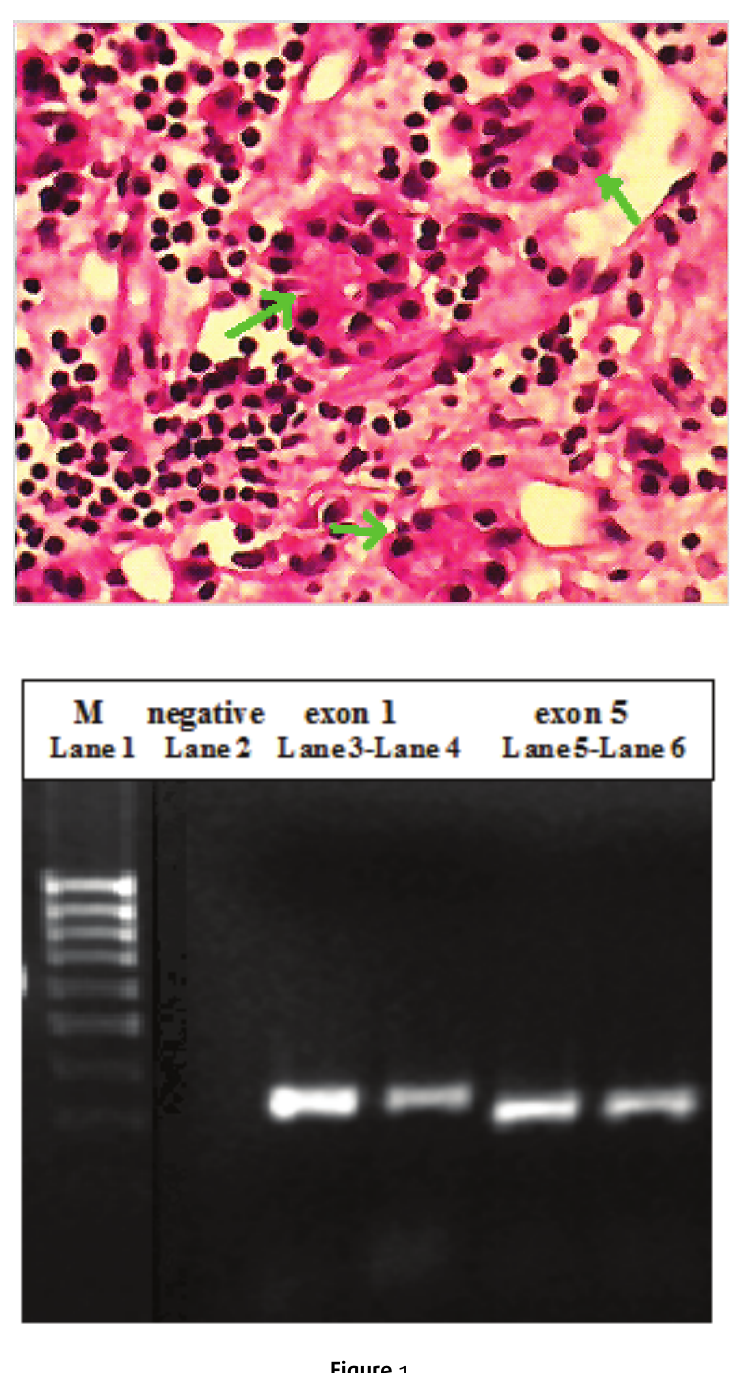
PCR products on acrylamide gel using SSCP analysis was performed on apparatus using 12% acrylamide gels. Electrophoresis was run at 2–6 W and variable